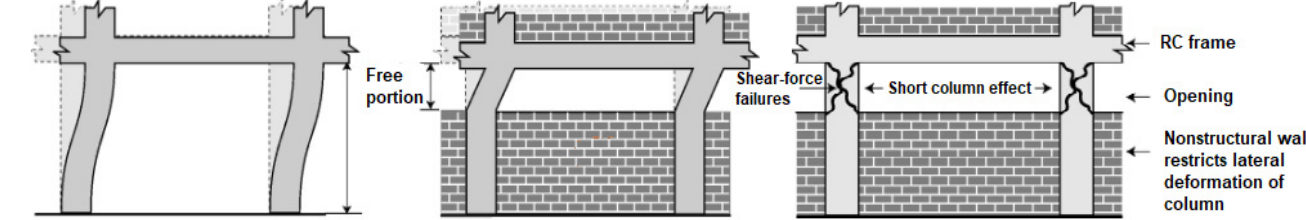
Figure 1. Behaviour of short and regular columns [42].